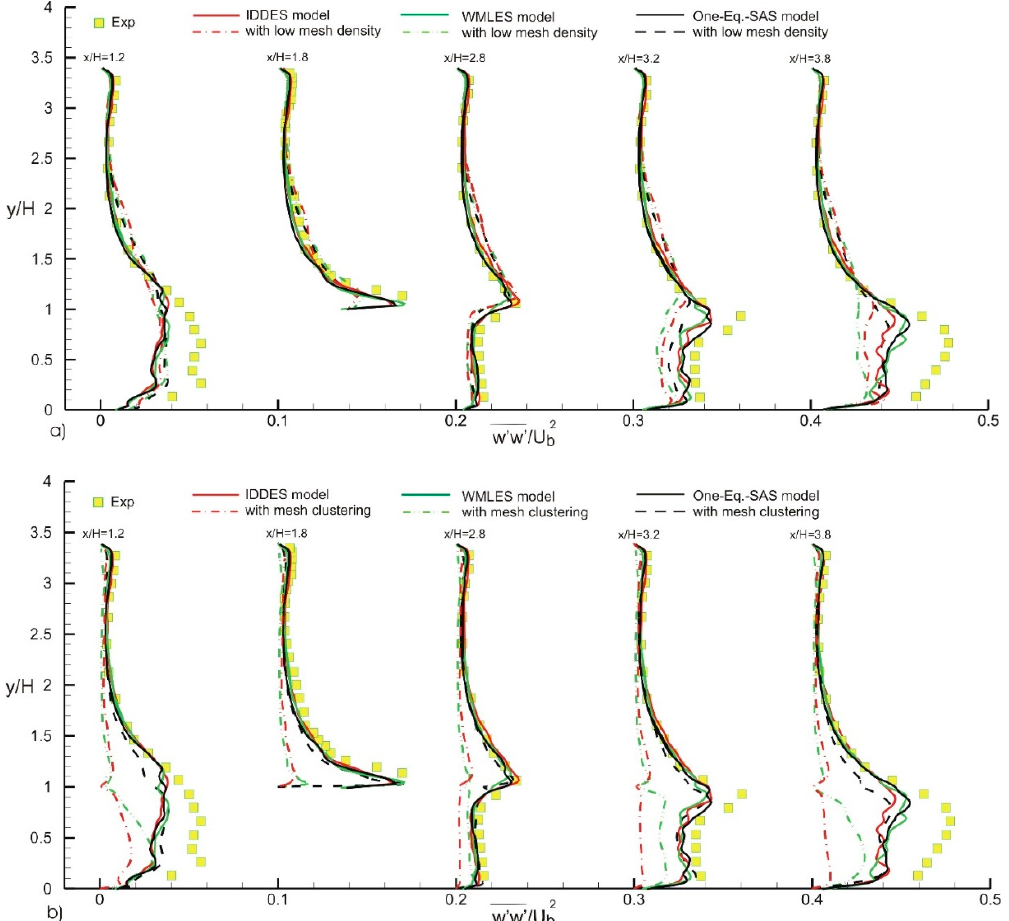
Figure 8. Effect of ( a ) mesh density, and ( b ) mesh clustering on the spanwise normalized Reynolds stress in the XY plane cutting through the center of the cube at z/H = 0.